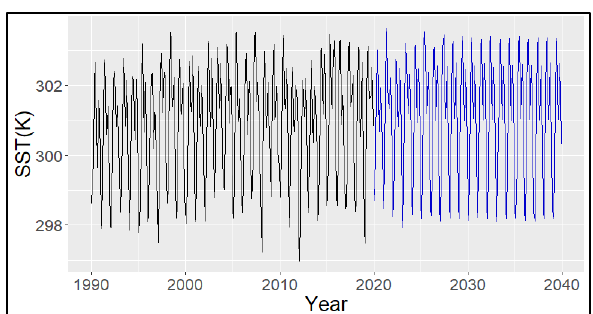
Figure 7 . SST forecast using NNAR for the period 2020 to